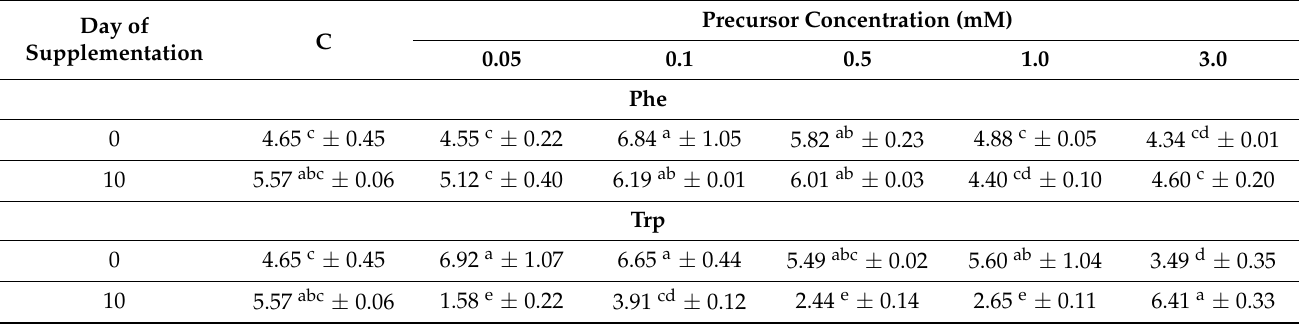
Table 2. Total amounts of soluble saccharides (g of GLU/100 g DW ± SD) in bioreactor-grown N. officinale microshoot cultures after precursor